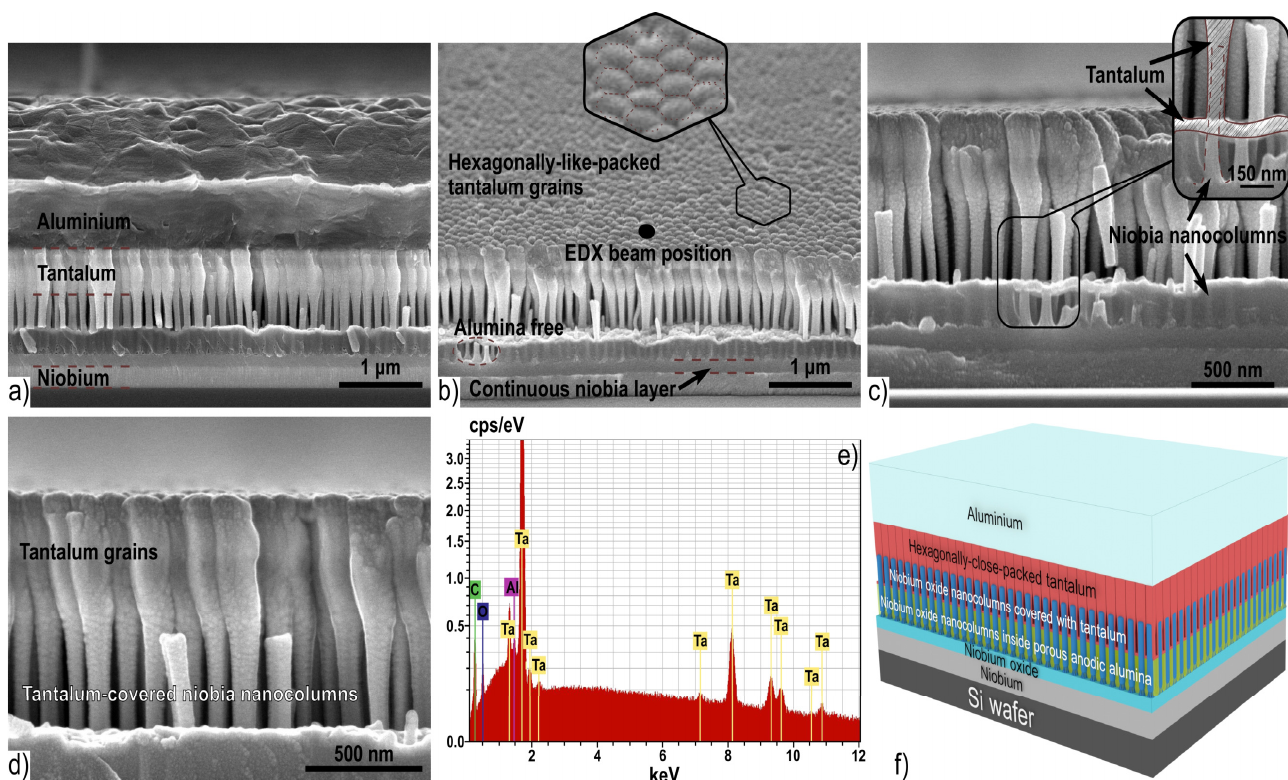
Figure 4. SEM cross-fractured ( a – d ) and 3D schematic views ( f ) of the Al (2000 nm)/hexagonally- packed Ta (500 nm) bilayer system, sputter-deposited on the first-level column-like anodic niobia 3D nanofilms. ( e ) EDX point analysis of the hexagonally-packed tantalum.